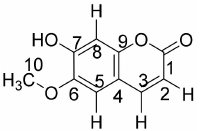
Figure 1. Structure of